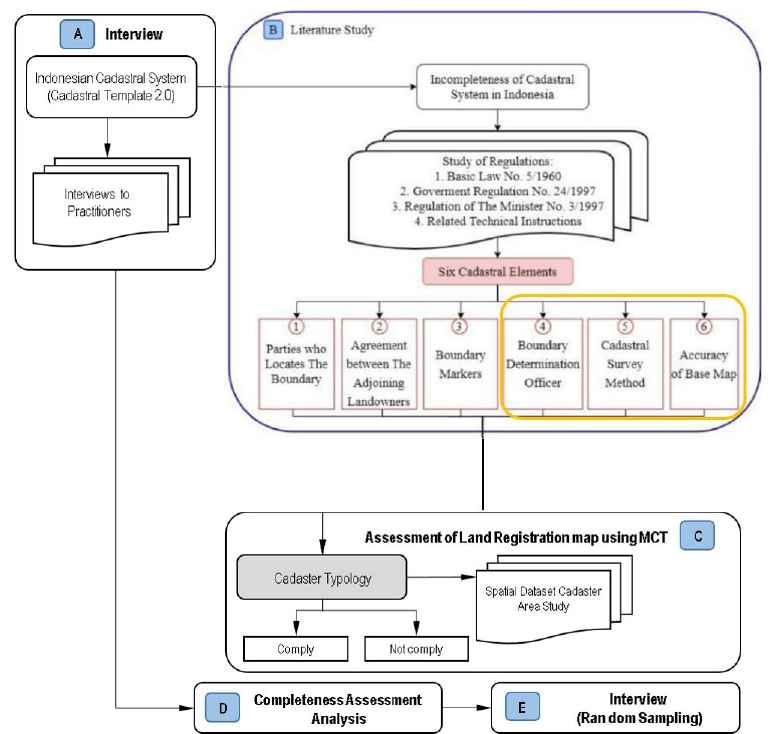
Figure 1. Work steps for the assessment of six cadastre elements [12].: (A) Interviews, (B) Literature & Regulations reviews, (C) Assessment of Land Registration Map using MCT, (D) Completeness Assessment Analysis, and (E) Random Interview.